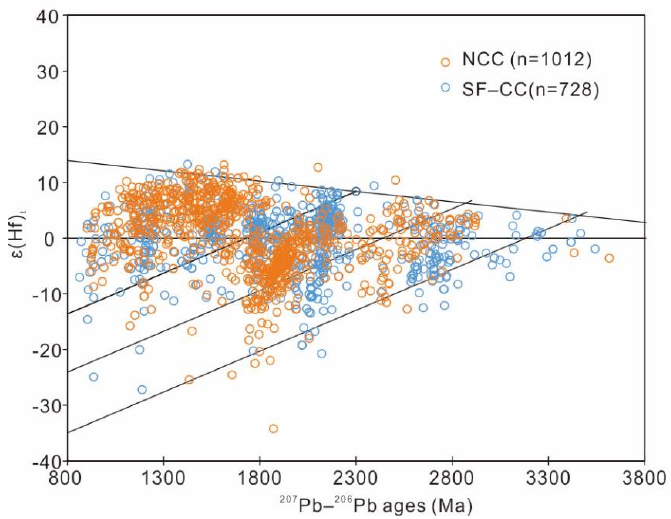
Figure 10. ε Hf(t) versus age diagrams of late Meso- to early Neoproterozoic successions in NCC and SF–CC. The NCC data are from [19,20,22] and this study. The SF–CC data are from [111–114]. Figure 10. εHf(t) versus age diagrams of late Meso - to early Neoproterozoic successions in NCC and SF – CC. The NCC data are from [19,20,22] and this study. The SF – CC data are from [111 – 114].